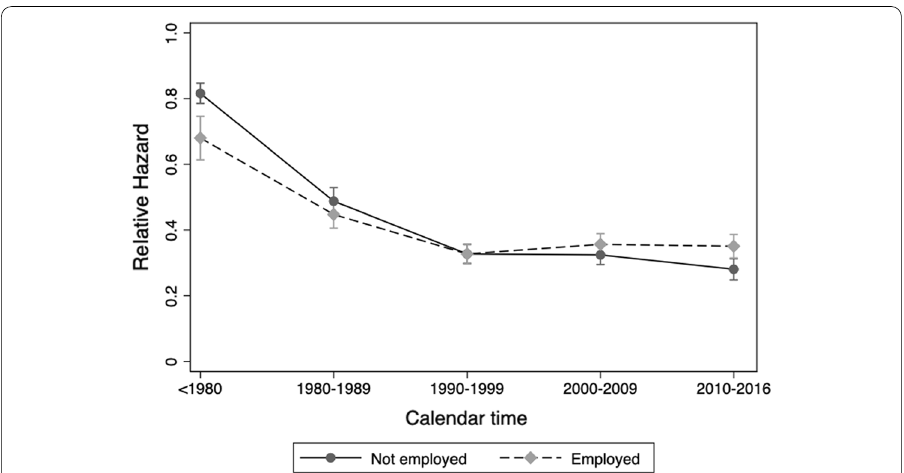
Fig. 2 Relative hazard of transition to motherhood over time for employed and non-employed women, Italy. Source: Author’s elaboration on FSS 2016 data